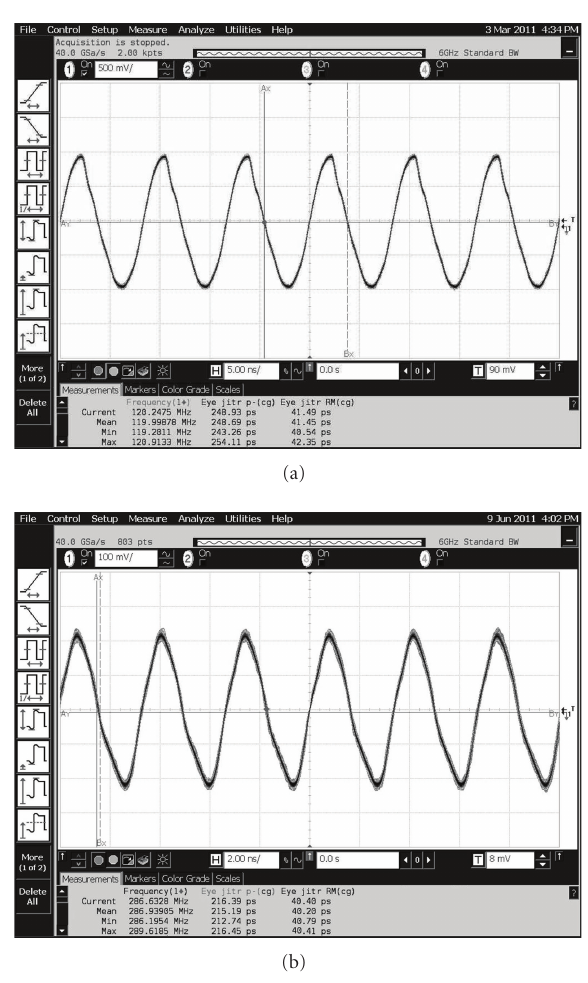
Figure 17: Measured results of interpolated flying adder (multi- phase ADPLL at 171 MHz), (a) Output at 120 MHz with P k − P k = 248 . 7 ps, (b) Output at 286MHz with P k - P k = 215 . 2 ps.